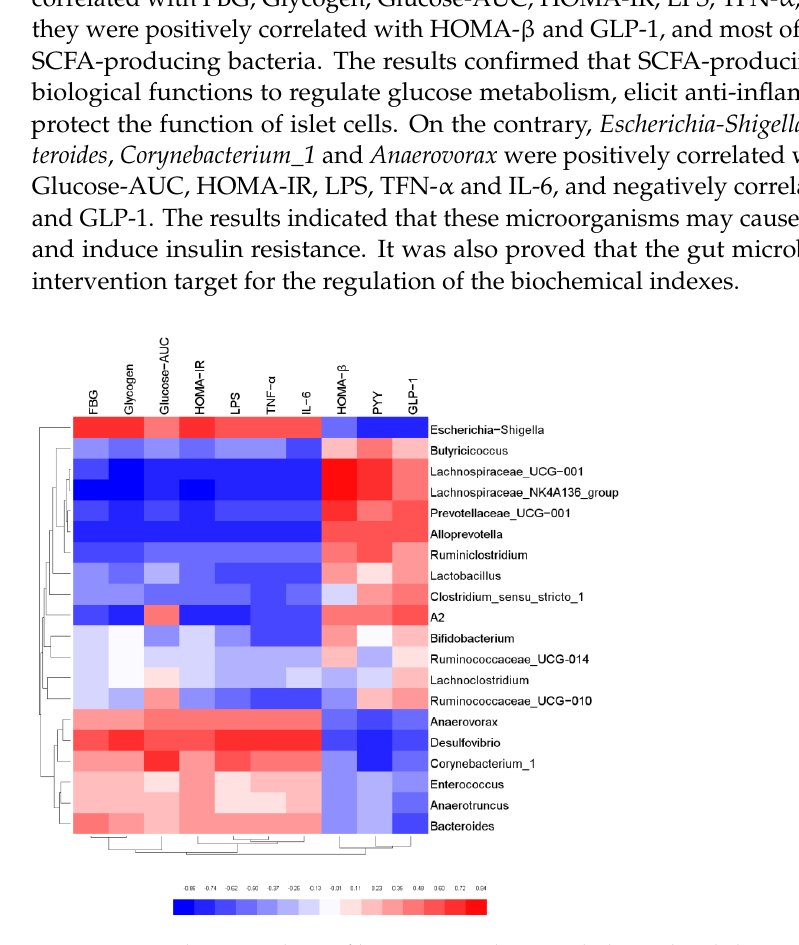
Figure 7. Correlation analysis of key gut microbiota and physical and chemical indicators.